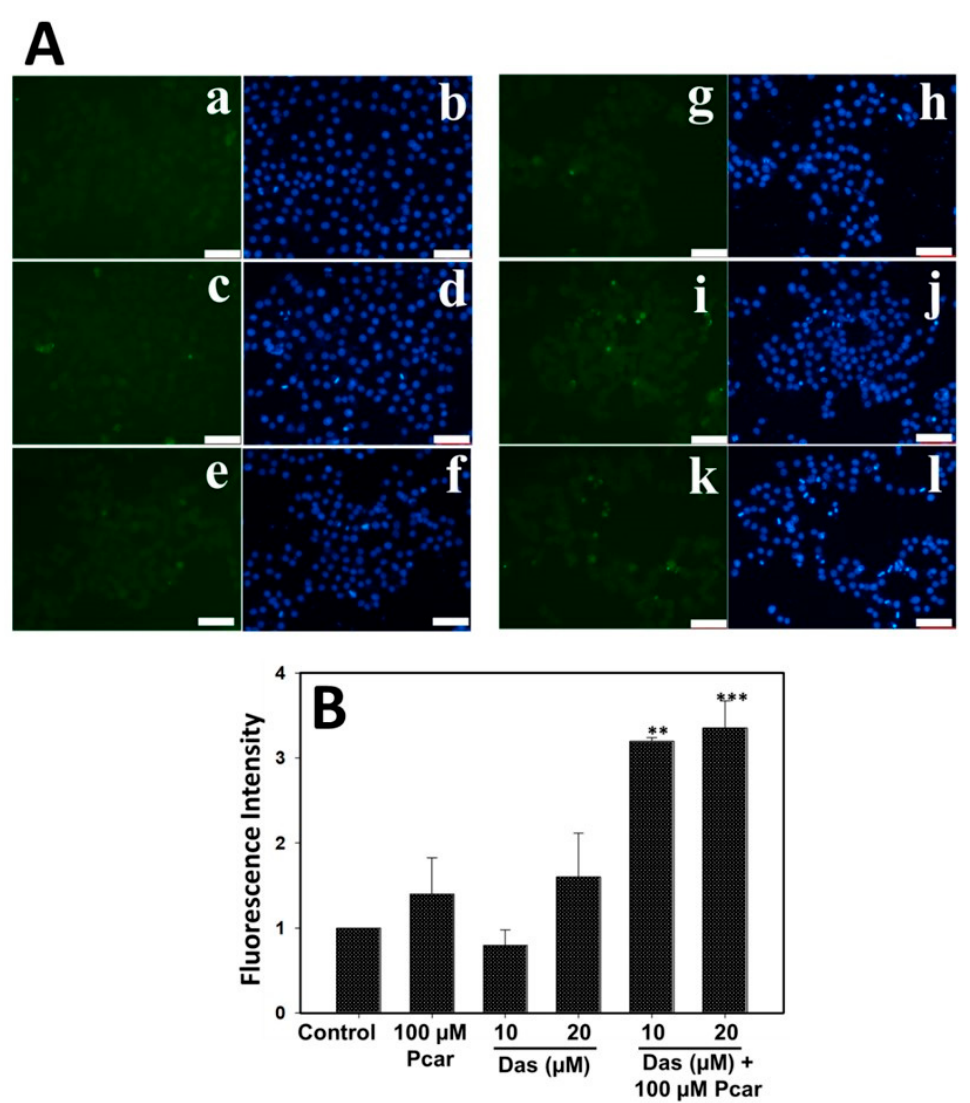
Figure 4. ROS generation in HepG2 cells was determined by DCFDA staining. ( A ) Fluorescence microscopy images show increased green fluorescence in Pcar and Das combination treatment group indicating increased ROS generation. ( B ) Quantitative analysis was performed by measuring the fluorescence of 3 independent areas. ( a , b ) Control; ( c , d ) 100 µM Pcar; ( e–h ) 10 and 20 µM Das; ( i–l ) 100 µM Pcar + 10 and 20 µM Das. Data represented as mean ± standard error (SE) obtained from three (n = 3) different experiments, ** p < 0.01, *** p < 0.001. Scale bar 100 µm.